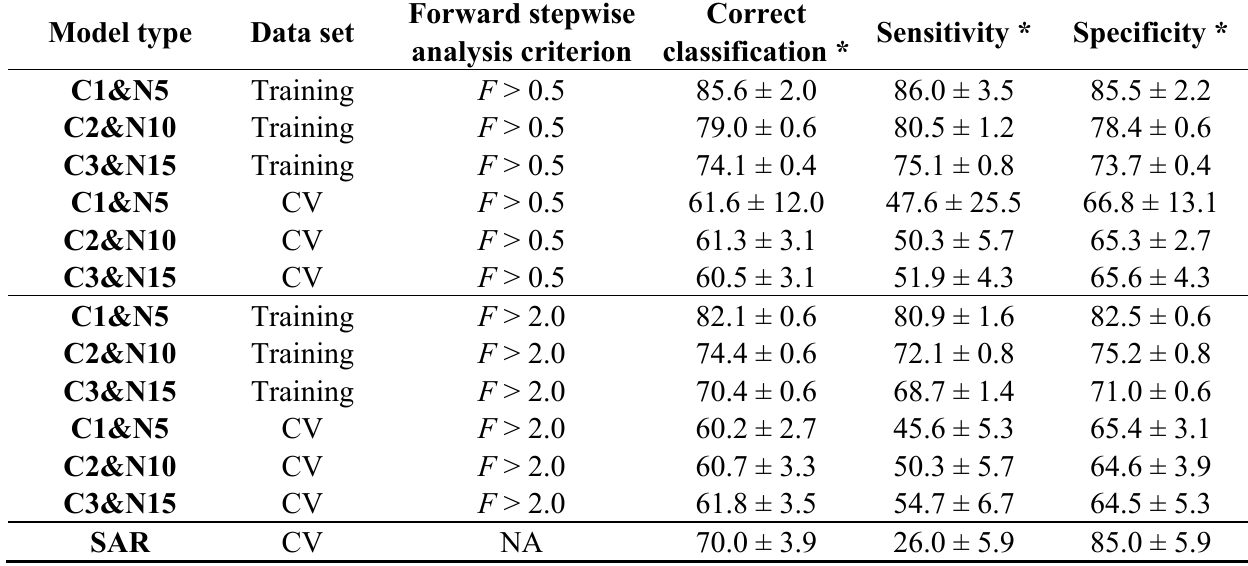
Table 4. Results of training and tenfold cross-validation for SDAR LDA and SAR DF models of inhibitors and non-inhibitors of CYP2D6.